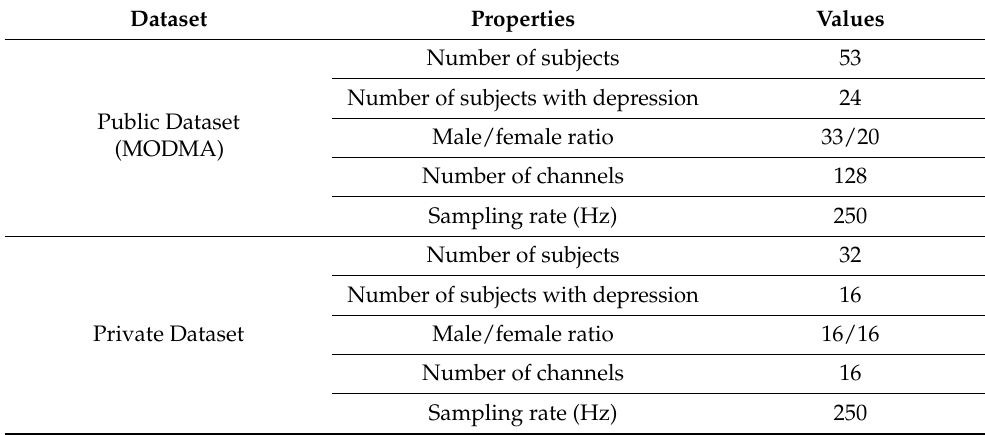
Table 1. Properties of datasets with data.